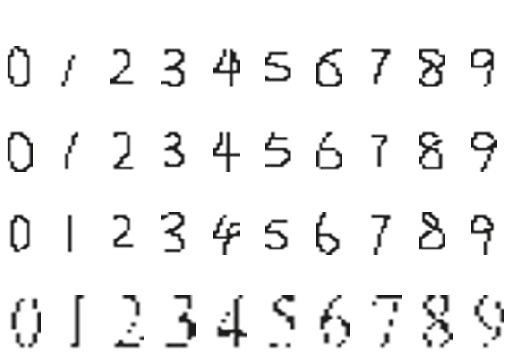
Figure 8: Training samples.